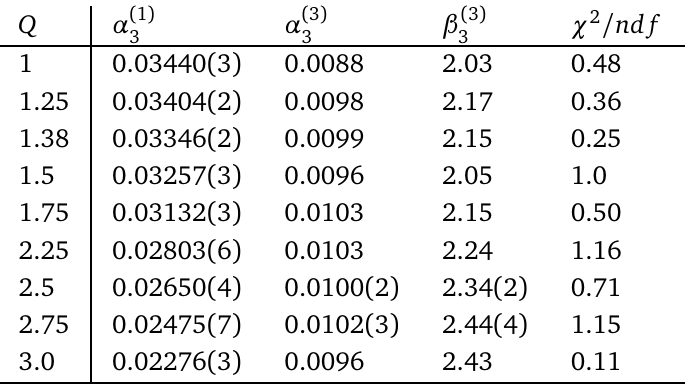
Table B.4: Numerical results for the parameters of the ansatz (154) in the case of P